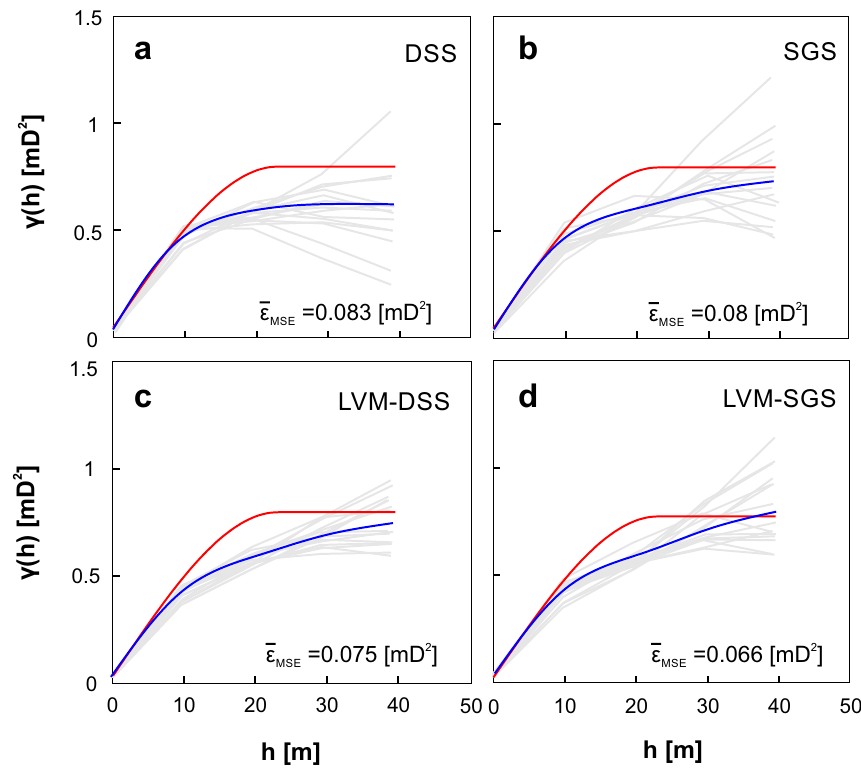
Figure 11. Experimental variograms (gray) for 15 realizations of DSS ( a ), SGS ( b ), LVM-DSS ( c ) and LVM-SGS ( d ) plotted together with the average over all realizations (blue) and the considered variogram model (red), which is described by a nugget of 0.05 mD 2 , a range of 23 m and a sill of 0.75 mD 2 . Visual